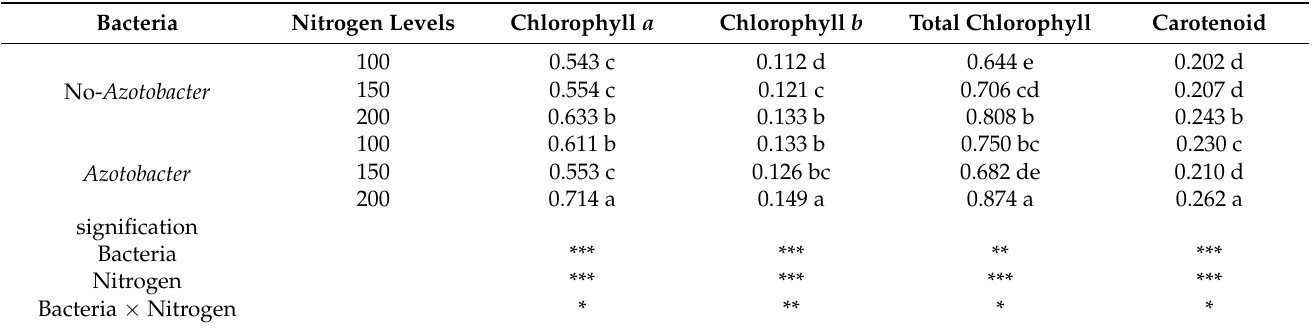
Table 3. Photosynthesis pigments content (mg/gFW) in hydroponically grown lettuce influenced by Azotobacter under different nitrogen levels.